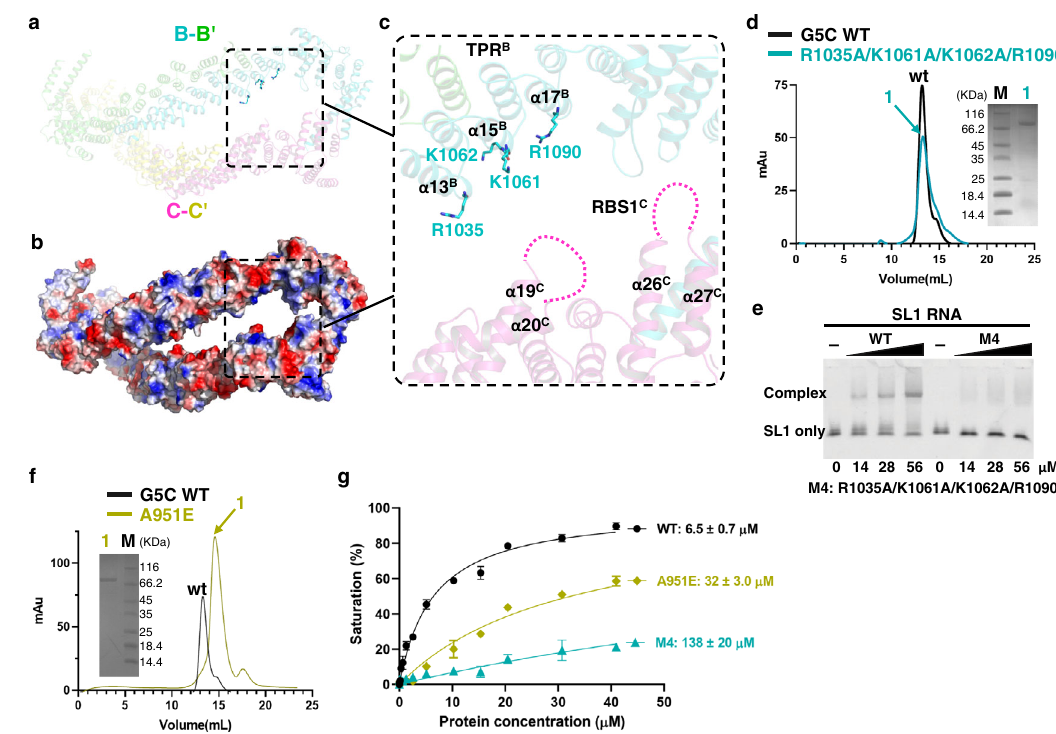
Fig. 6 | Potential RNA binding surface ofthe G5Cdecamer. a In the structure of the G5C decamer, B – B ’ and C – C ’ are two spatially adjacent dimers, with B, B ’ , C, and C ’ colored cyan, green, pink, and yellow, respectively. b Electrostatic sur- face of the two adjacent dimers, B – B ’ and C – C ’ . c Close-up view of a large positively charged concave surface as the potential RNA binding site formed by theTPRdomainofmoleculeB(TPR B )andtheRBS1regionofmoleculeC(RBS1 C ). The four basicTPR residues within α 13 – α 17,including R1035, K1061,K1062, and